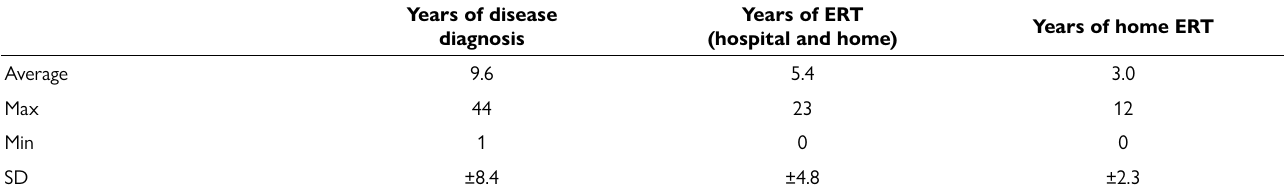
Table 2. Diagnosis and Treatment Time